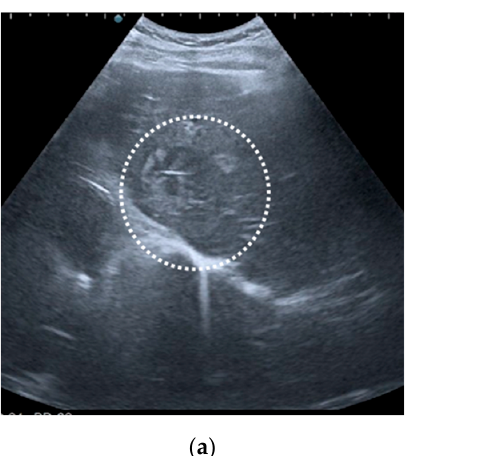
There were 37 lesions from 39 cases (94.8%) classified as probably HCC (LR-4) that were finally diagnosed as HCC (Figure 8).